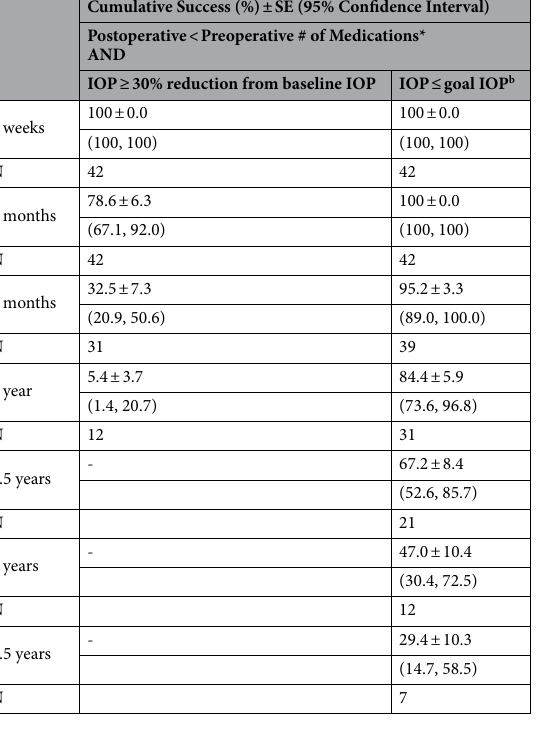
Table 3. Life table. SE = standard error of the mean; N = number of eyes; IOP = intraocular pressure. *Patients with no medications preoperatively were excluded from this analysis. b Goal IOP was determined by the fellowship-trained glaucoma specialist based on IOP and glaucoma